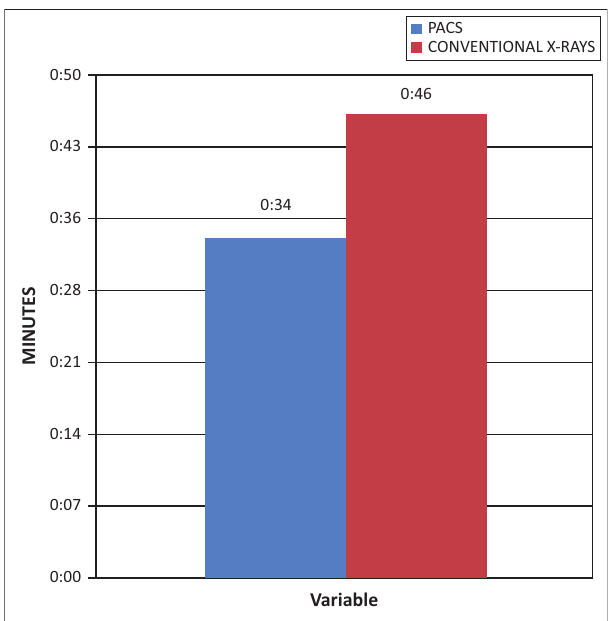
FIGURE 1: Patient waiting times in minutes for chest radiographs at Hospital A (PACS) ( N = 255) and Hospital B (conventional) ( N = 255).